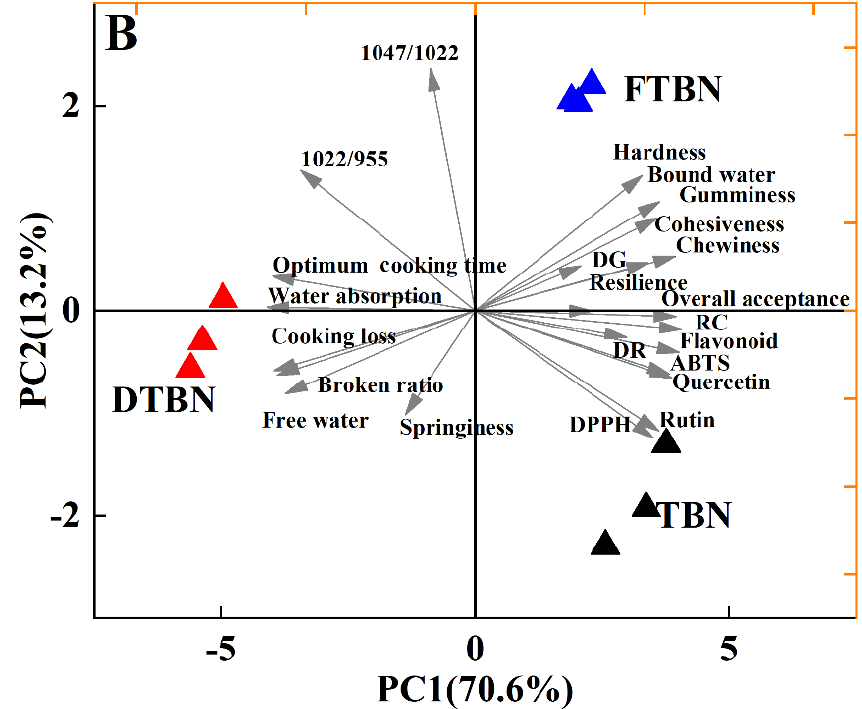
Figure 5. Association of quality of Tartary buckwheat noodles with the changes in the water distribution and starch properties. Pearson correlation coefficients ( A ) and Principal Component Analysis (PCA) ( B ). DG, degree of starch gelatinization; DR, degree of starch retrogradation; RC, relative crystallinity; TBN, fresh Tartary buckwheat noodles; DTBN, dried Tartary buckwheat noodles; FTBN, frozen Tartary buckwheat noodles.